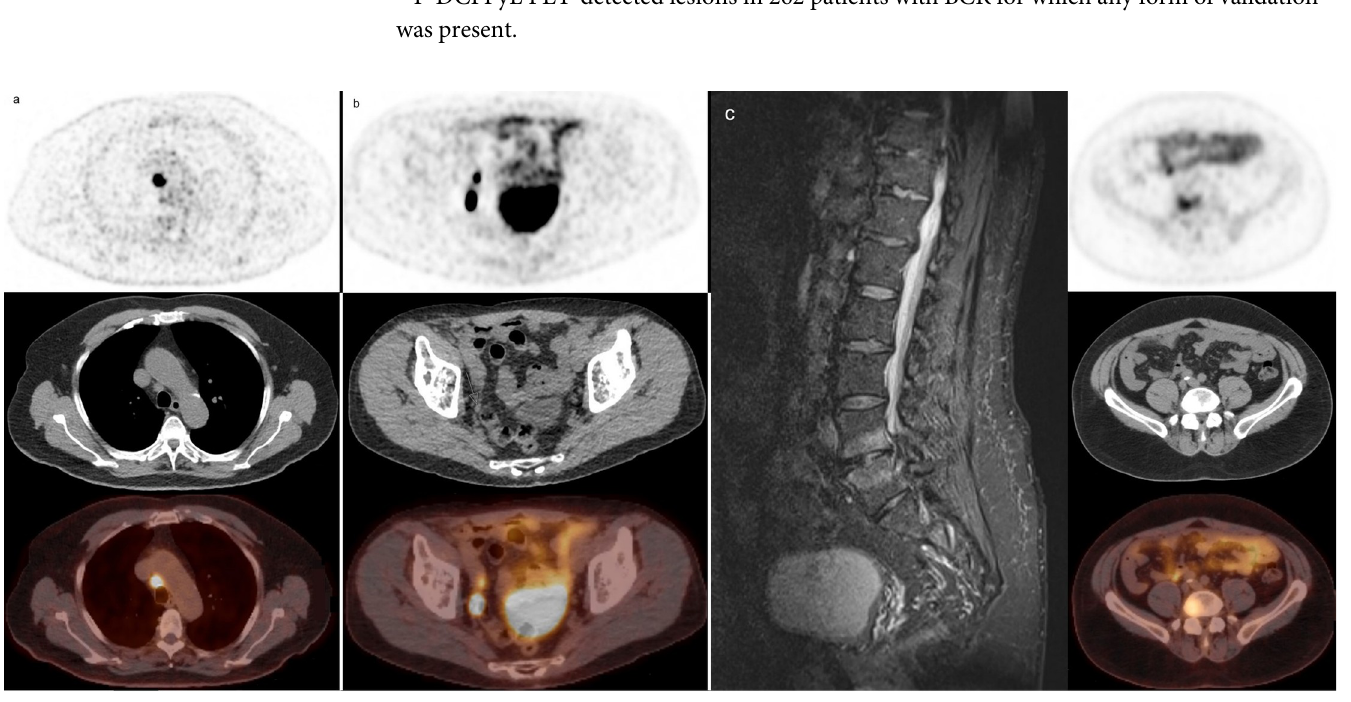
Fig 3. Examples of validated lesions through our composite validation method (PET/ CT/ Fused PET/CT) . a . True positive lesion: mediastinal lymph node metastasis of PCa, confirmed with endobronchial ultrasound guided biopsy. b . True positive lesions: two lymph nodes, proven to be metastases of PCa by extended pelvic lymph node dissection c . False positive lesions: high PSMA expression in sclerotic substrate lateral to the right side of the vertebral body of L4 and L5, suspicious for degenerative lesions instead of PCa metastases on additional MRI imaging.